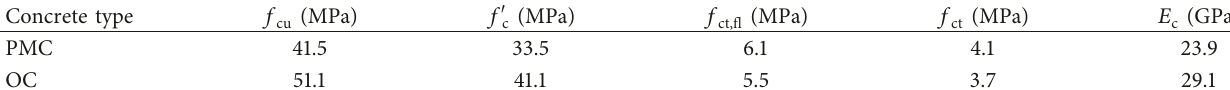
Table 3: Material properties of concrete.